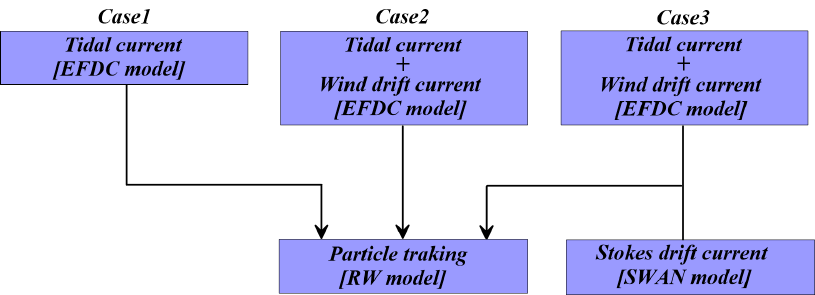
Figure 2. Flowchart of the oil spill model.